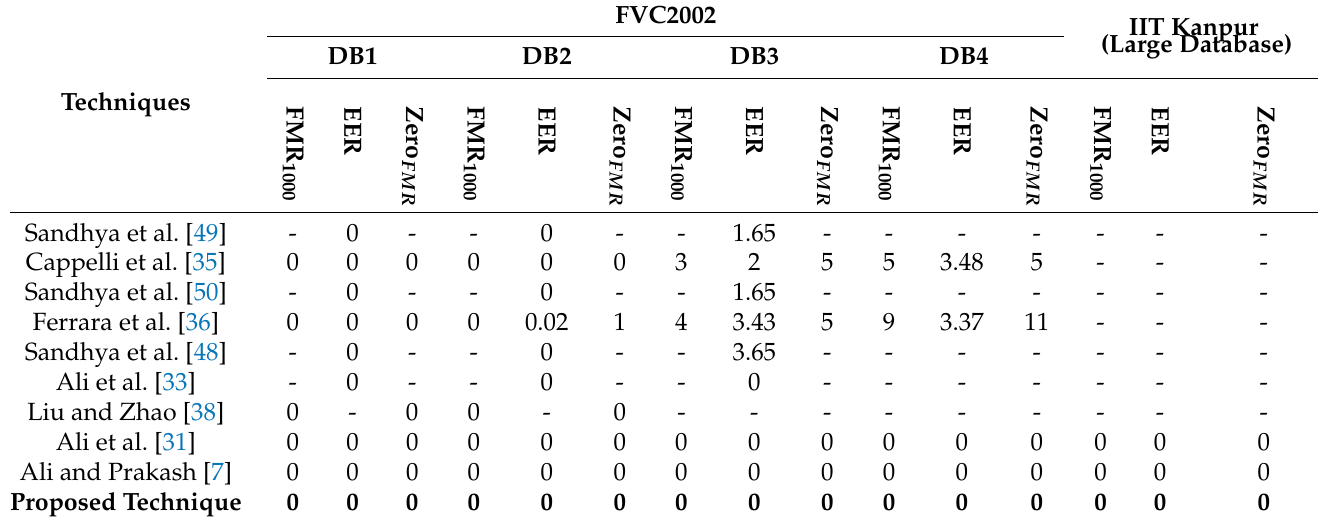
Table 3. Comparison of the EER values of the proposed technique with the other techniques by following the 1vs1 protocol (values are in percentage).